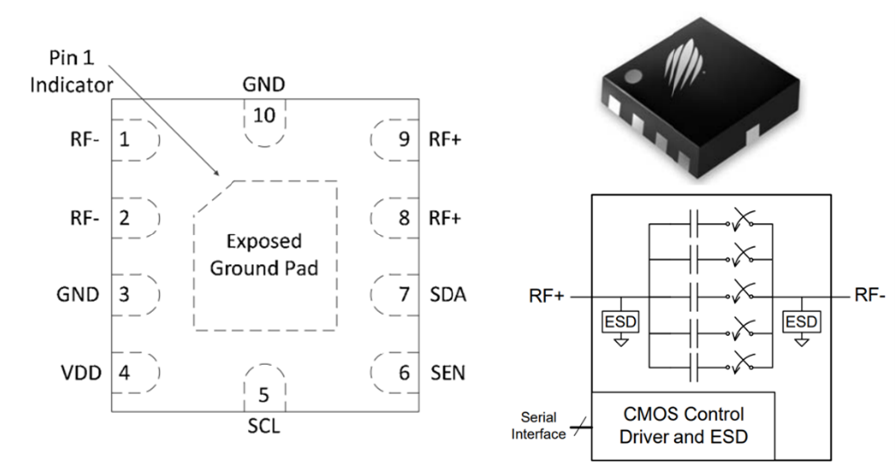
Figure 4. DTC structure and its pinout.